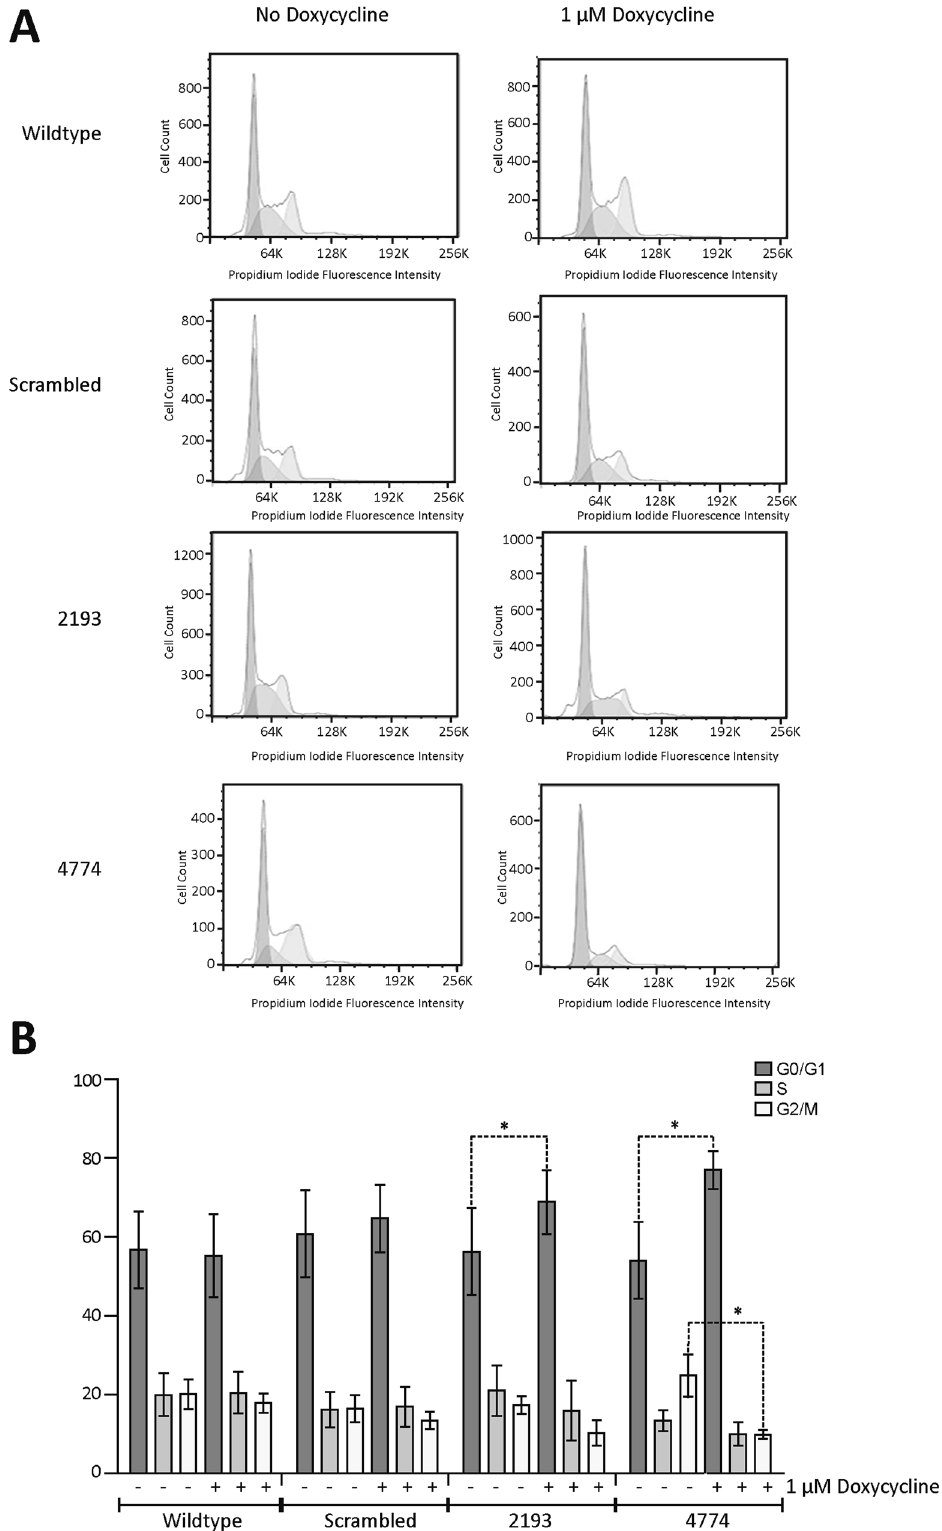
Figure 2. Loss of USP9X results in ReNcell VM cell accumulation in the G0/G1 phase of cell cycle. ( A ) Flow cytometric analysis of ReNcell VM cells after 72 hours of doxycycline treatment. Representative of three biological replicates. ( B ) Quantitation of percentage of cells in each cell cycle phase from three biological replicates. All data are shown as the means ± SEM. Statistical significance was assessed by the unpaired Student’s t test. * p <